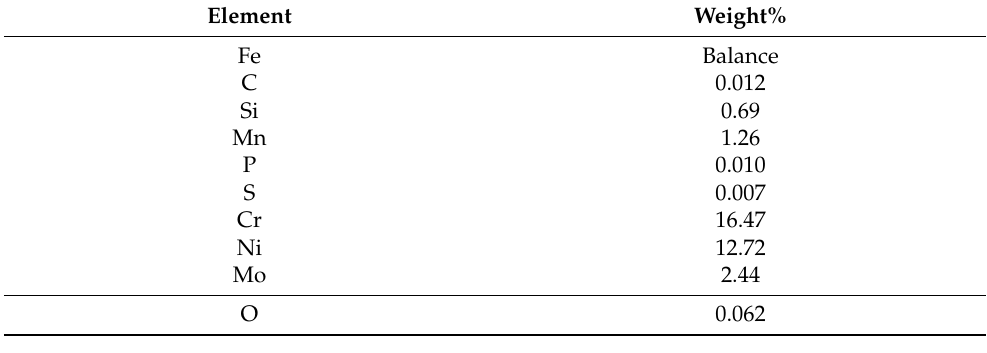
Table 3. The processing parameters of SLM.